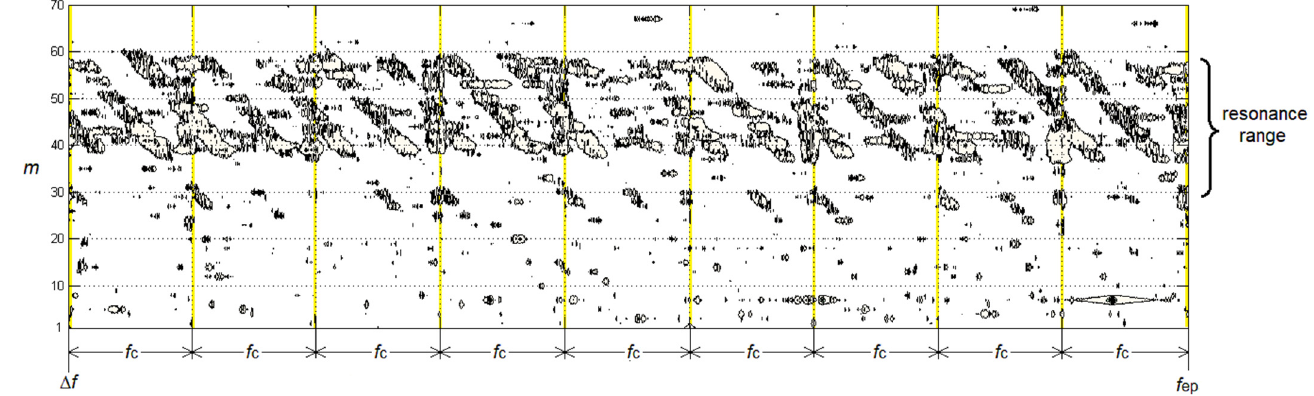
Figure 8. F-F image of the frequency spectrum of the vibration acceleration of the motor’s outer casing with a damaged bearing cage ( f P = f ep ).